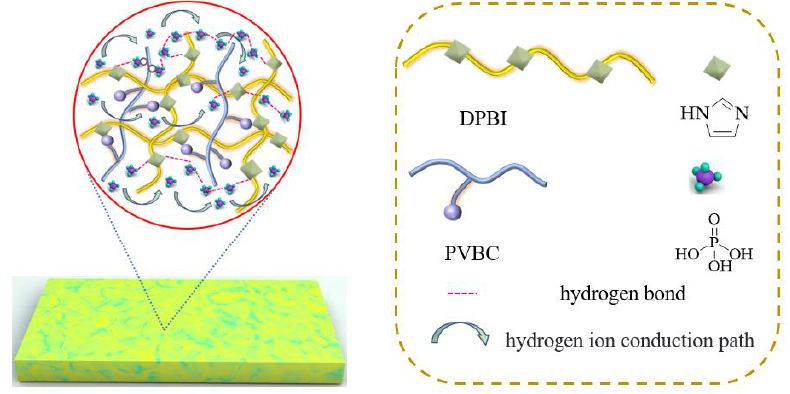
Scheme 2. Schematic of proton transport of PA@ DPBI- x PVBC membrane.